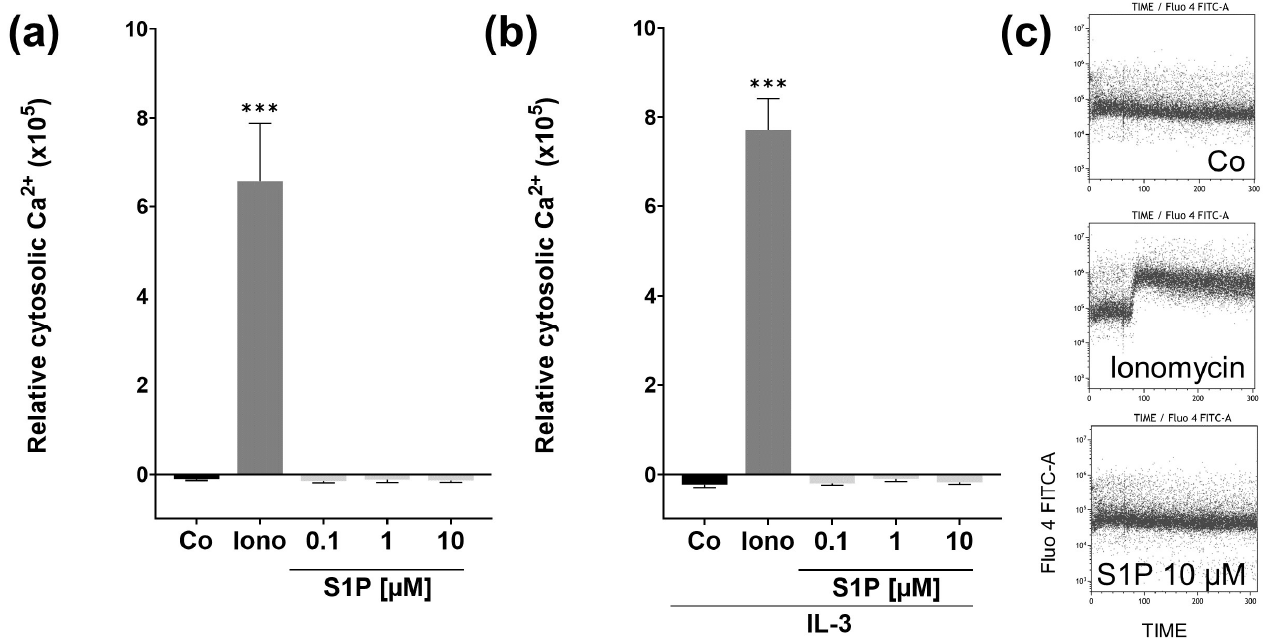
Figure 3. Calcium flux assay. Changes in basophil cytosolic Ca 2+ levels after stimulation with S1P. Purified basophils were incubated with Fluo-4 AM (4 µM), and calcium flux was measured by flow cytometry. ( a ) Differences in relative cytosolic Ca 2+ concentrations to baseline, after stimulation with 500 nM ionomycin (positive control), 0.1, 1, or 10 µM S1P ( n = 6). ( b ) Changes in relative cytosolic Ca 2+ concentrations after priming with IL-3 (10 ng/mL) and stimulation with either ionomycin or different concentrations of S1P ( n = 4). ( c ) Changes in fluorescence over 300 s during application of RPMI, ionomycin, and 10 µM S1P. Data are shown as mean + SEM, p -values (*** ≤ 0.001). Significances are calculated in relation to the Co group.